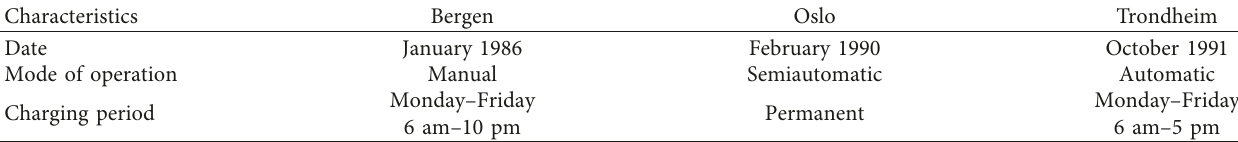
Table 1: Main characteristics of Bergen, Oslo, and Trondheim toll cordons.